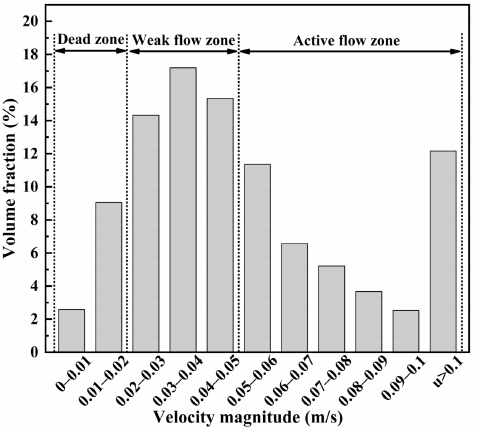
Figure 6. Velocity interval distribution of liquid phase in molten bath (Case